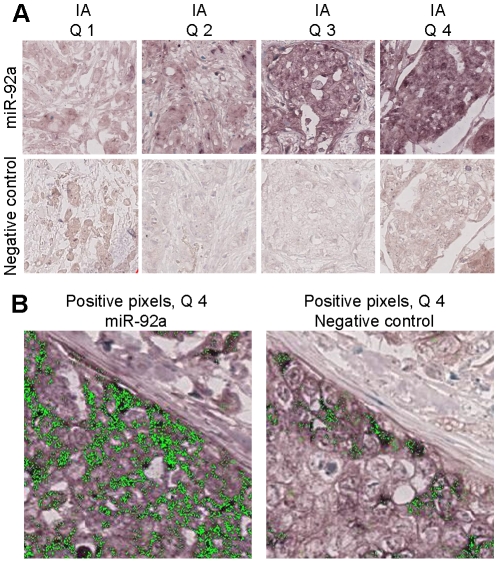
MiR-92a expression in breast cancer samples.
A) In situ hybridization was performed on a breast cancer tissue microarray using a detection probe for miR-92a and a negative control probe. Tumours were divided into quartiles 1–4 (Q1–Q4) based on the staining intensity (Q1 = weakest staining, Q4 = strongest staining). 20× magnification. B) Example of positive pixel definition of representative Q4 tumour stained with miR-92a probe and negative control probe. 40× magnification.